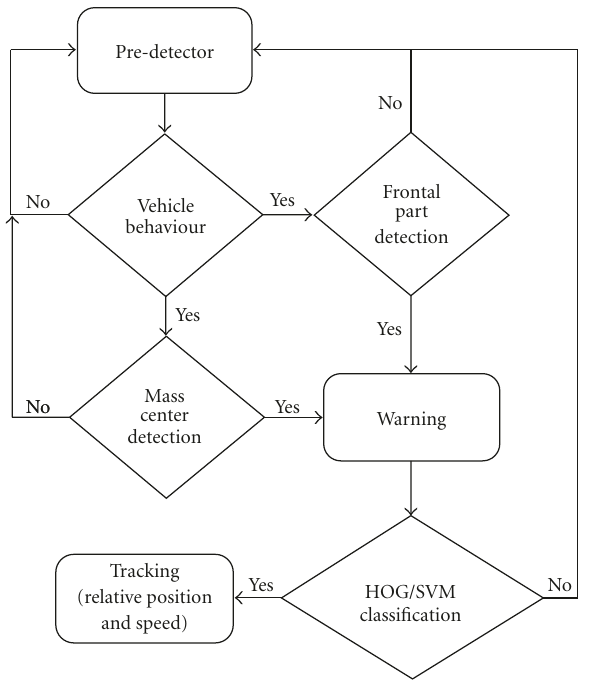
Figure 6: Side vehicle detection flow